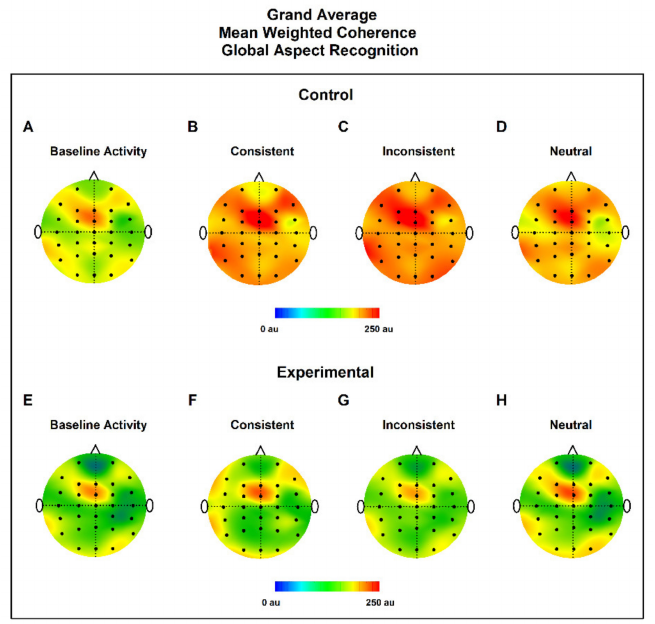
Figure 4. Grand average topographic maps of MWC for Global Aspect Recognition. Upper panel shows control group in EEG baseline activity ( A ), Consistent ( B ), Inconsistent ( C ) and Neutral conditions ( D ). Lower panel shows experimental group in EEG baseline activity ( E ), Consistent ( F ), Inconsistent ( G ) and neutral conditions ( H ). In all cases the maximum value of the MWC was found near FCZ located in the frontal lobe.